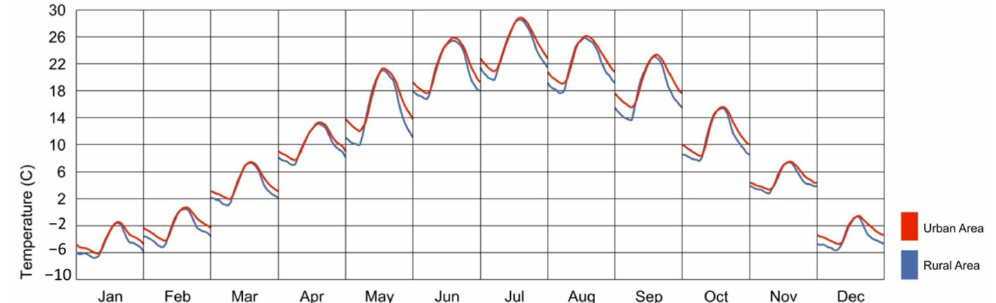
Figure 16. Typical day temperature profiles for urban and rural